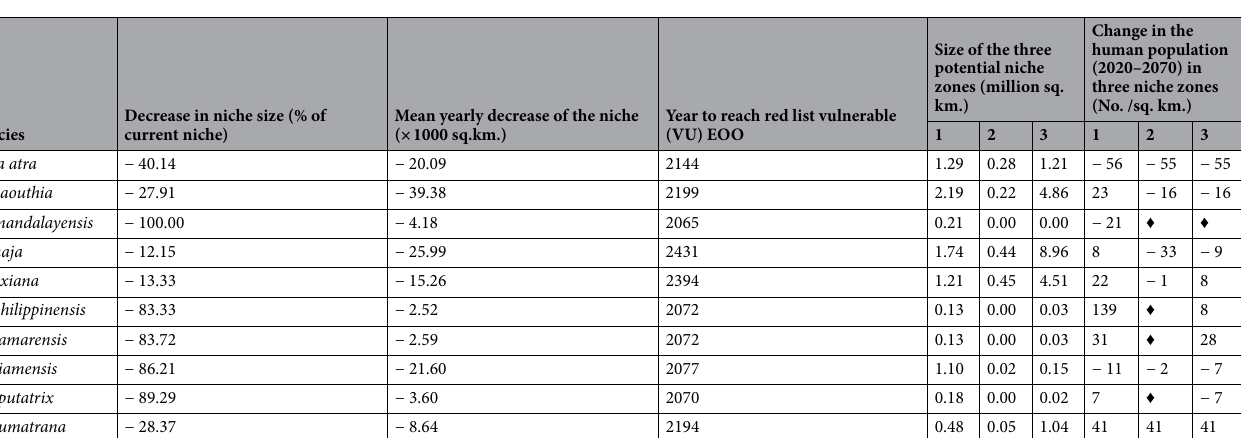
Table 1. Considering the RCP 6.0 scenario, the climatic niche size and human population in the range of the studied species at present time and in the next 50 years. Gradual decrease in niche size and increase in human density are the threats on the Asian Naja. ♦ As there was no suitable climatic niche, so the population could not be calculated.